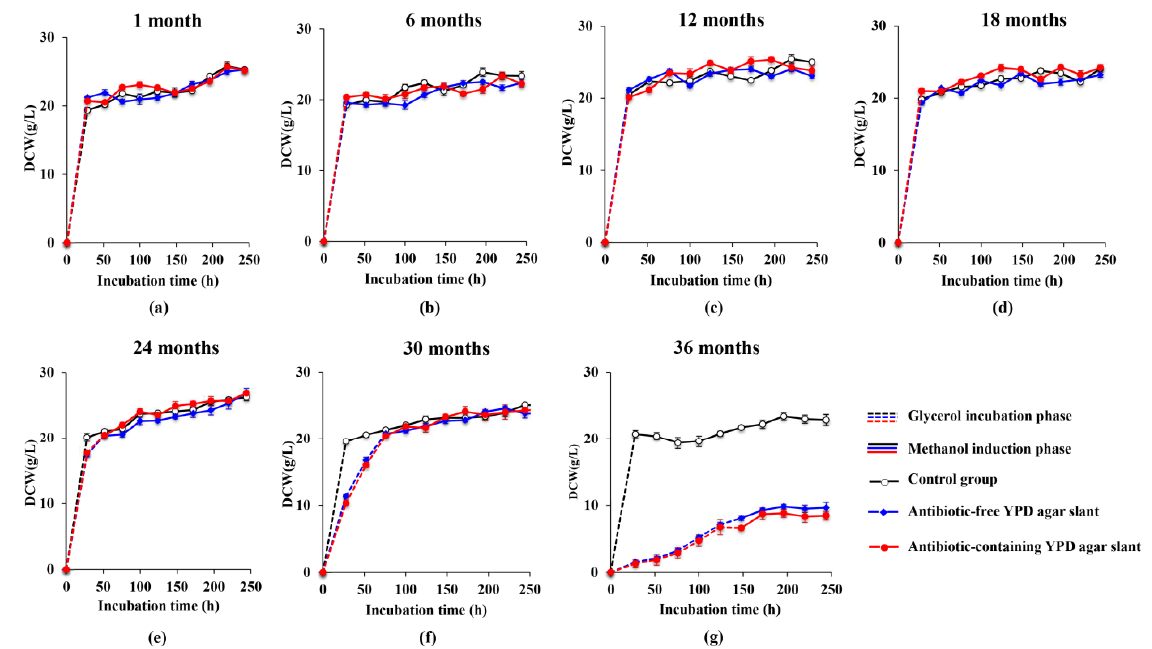
Figure 2. Curves of growth abilities of the engineered yeast GS115-3.5K-P1-2 preserved in the YPD agar slants at 4 ◦ C for different months ( a – g ). Dotted lines: glycerol incubation phase; Solid lines: methanol induction phase; Black hollow lines: the control group; Blue solid lines: the antibiotic-free YPD agar slant; Red solid lines: the antibiotic-containing YPD agar slant.